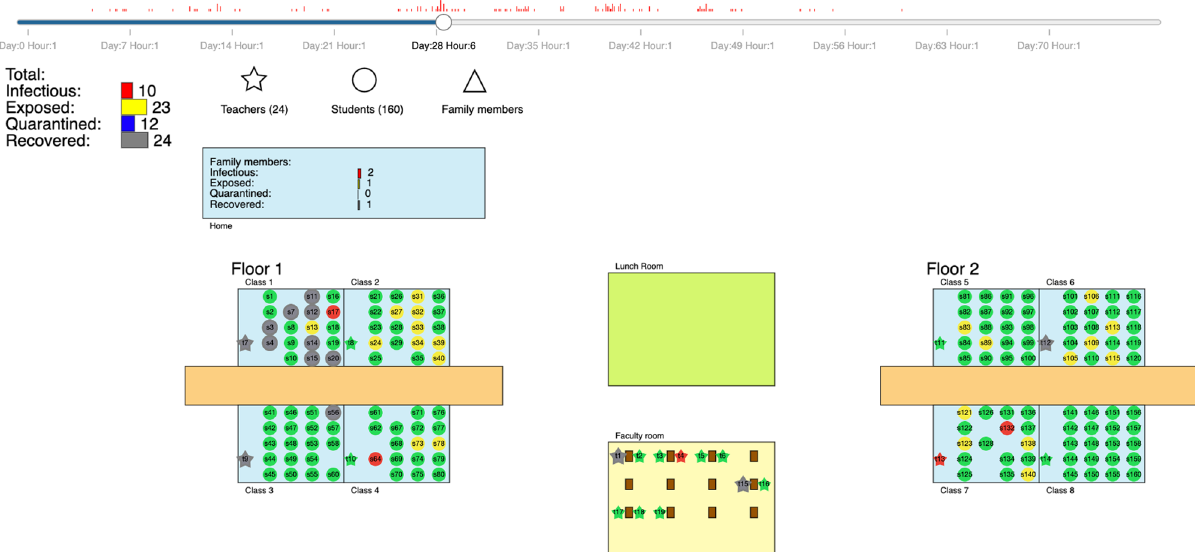
Fig. 10 The “ outbreak simulation view ” in the online visualization displays the schedule of students and teachers over time, illustrated in a schematic view of the respective school. Agents (nodes) change their colour according to their current infection state: susceptible (green), exposed (yellow), infectious (red), recovered (grey). Red bars on the timeline (top) indicate when infections occur. Outside of school-hours, agents spend their time at home (indicated by a single box on the top left) where infections with family members can occur. Family members are hidden from the animation, but their state is tracked as well, and displayed as a histogram on top of the home. A summary of the state of all agents is displayed on the top left corner below the time (we use the absolute value of the difference between 1 and the slope as distance measure). Heatmaps of values for the different distance measures and different parameter combinations are shown in Supplementary Fig. 1. The median values and [0.025; 0.975] con fi dence intervals for all seven distance measures are shown in Supplementary Fig. 2. While there is some variation between the different distance measures, all con fi dence intervals overlap and we con fi rm that the optimal parameter choice only slightly depends on the chosen distance measure. We note that in our calibrated model, a signi fi cant number of simulations do not lead to further transmission within the school (63% for primary schools and primary schools with daycare, 44% for lower secondary schools, 55% for lower secondary schools with daycare, 44% for upper secondary schools and 40% for secondary schools). As the cluster tracing data does not contain such events, we cannot validate the number of these instances.